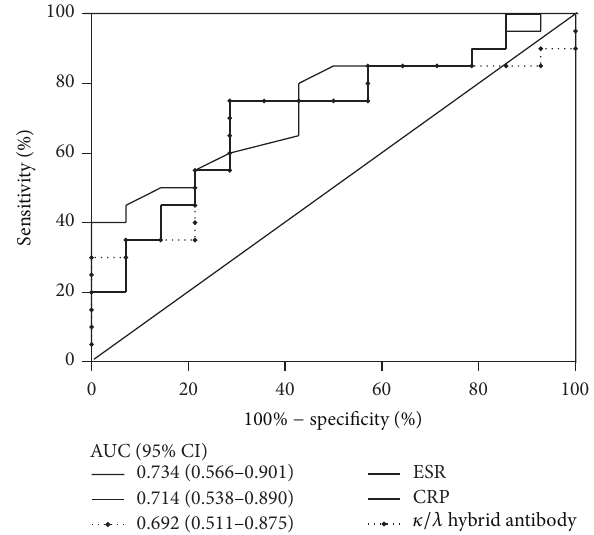
Figure 5: Receiver operating characteristic (ROC) curve analyses for 𝜅 / 𝜆 hybrid antibody, ESR, and CRP in discriminating moderate to high activity RA. The area under the curve (AUC) is presented. CI: confidence interval.